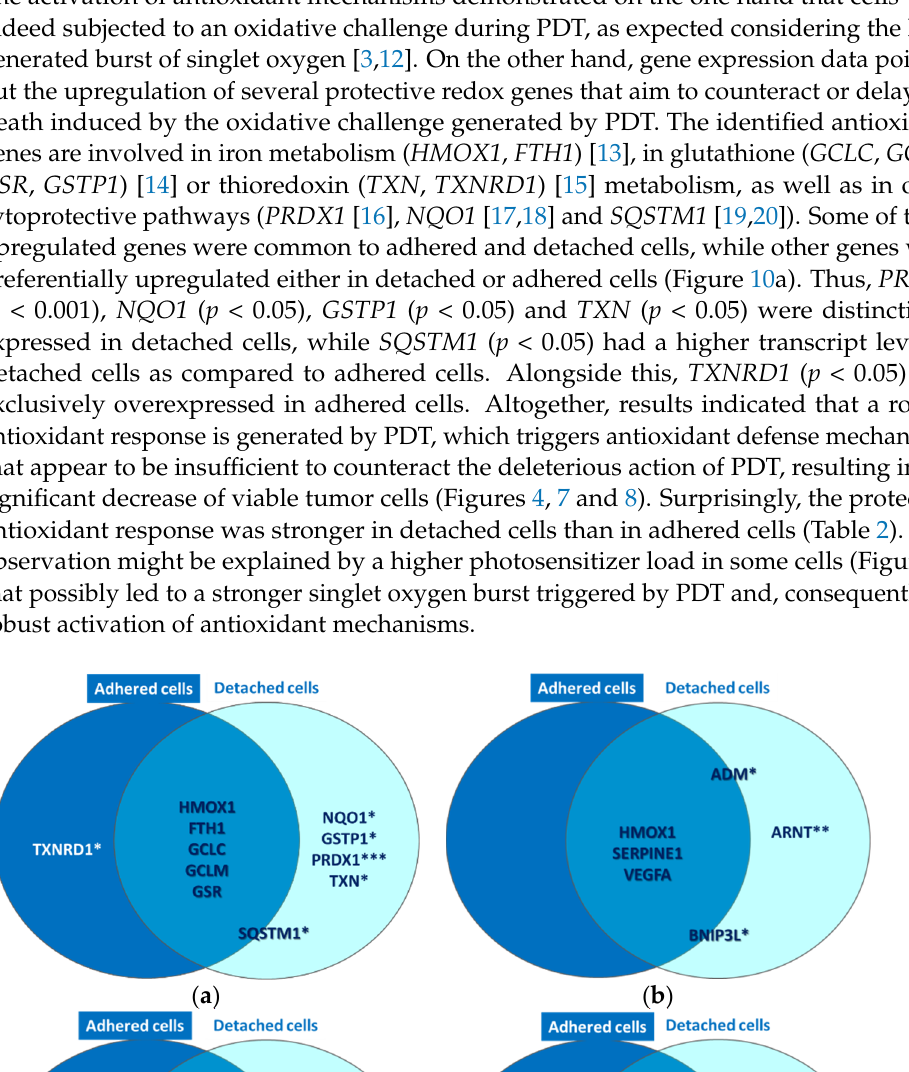
Figure 10. Common and distinctive gene expression patterns in adhered and attached HT29 tumor cells that were exposed to P2.2-PDT (10 J/cm 2 , 50 mW/cm 2 ) at 24 h post-PDT. Some selected genes with modified expression in PDT-treated cells as compared to untreated cells (1.5 < FR < −1.5, p < 0.05) are represented. These genes are involved in ( a ) oxidative stress, ( b ) Hypoxia signaling, ( c ) cell death, ( d ) DNA damage, ( e ) unfolded protein response and ( f ) inflammation. All the reported genes were upregulated, excepting those marked with downwards arrows. Genes placed at the borders of the two circles are expressed both in adhered and detached cells, but have higher expression in one of the two cell types. This comparison between gene expression levels in adhered and detached cells was performed with a paired samples t -test (* p < 0.05, ** p < 0.01, *** p < 0.001).